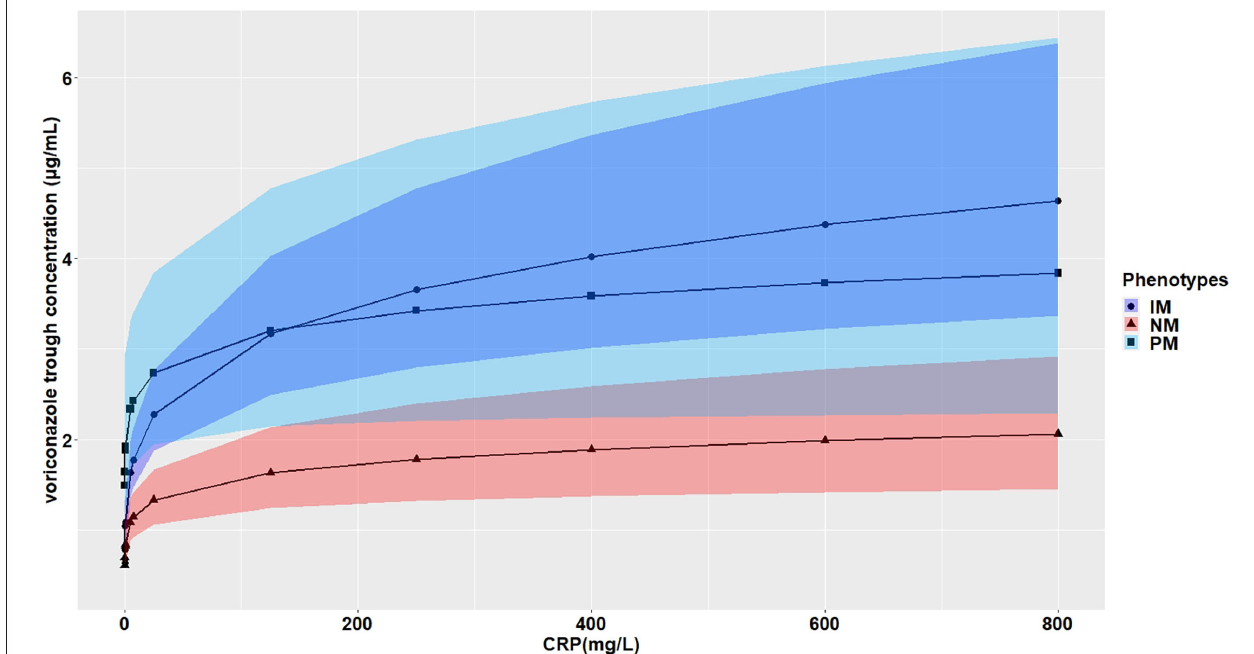
FIGURE 3 | Effects of the CRP levels on the voriconazole trough concentration (mg/ml) according to the CYP2C19 phenotypes. The figure illustrates the predicted voriconazole CDR as a function of CRP level from the multivariate generalized linear mixed-effects model. The curves with closed triangle, closed circle, and